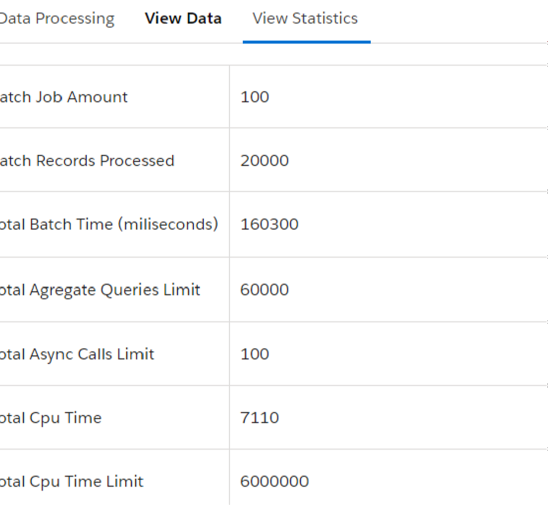
Figure 3. View Data tab of Salesforce Data Processor application created to analyse the data process- ing methods.